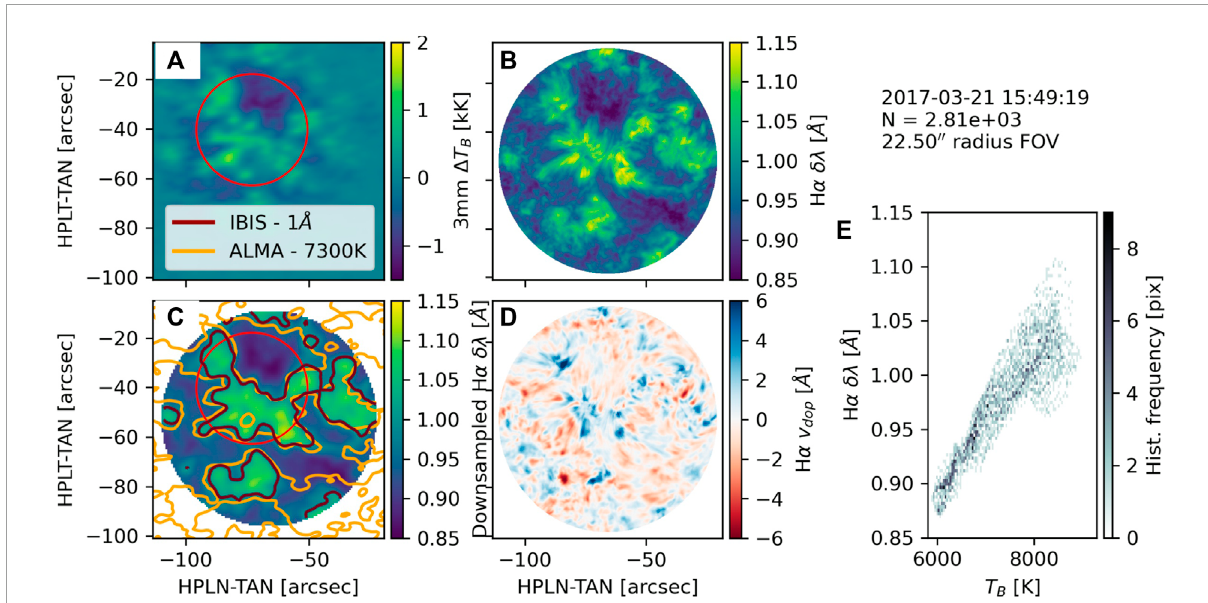
FIGURE 3 Overview of the primary data series used for this study: (A) ALMA Band 3 relative brightness temperature Δ T B ; (B) full resolution IBIS H α line width; (C) convolved and spatially down-sampled line width; (D) full resolution H α Doppler velocity; and (E) the joint probability distribution of brightness temperature and the line width within the 45 ′′ diameter red circle, which is a conservative estimate of the overlapping FOV. (C) shows contours of the ALMA 7300 K level (orange) and IBIS 1 Å line width level (dark red). An animation based on (A–D) is included in the online